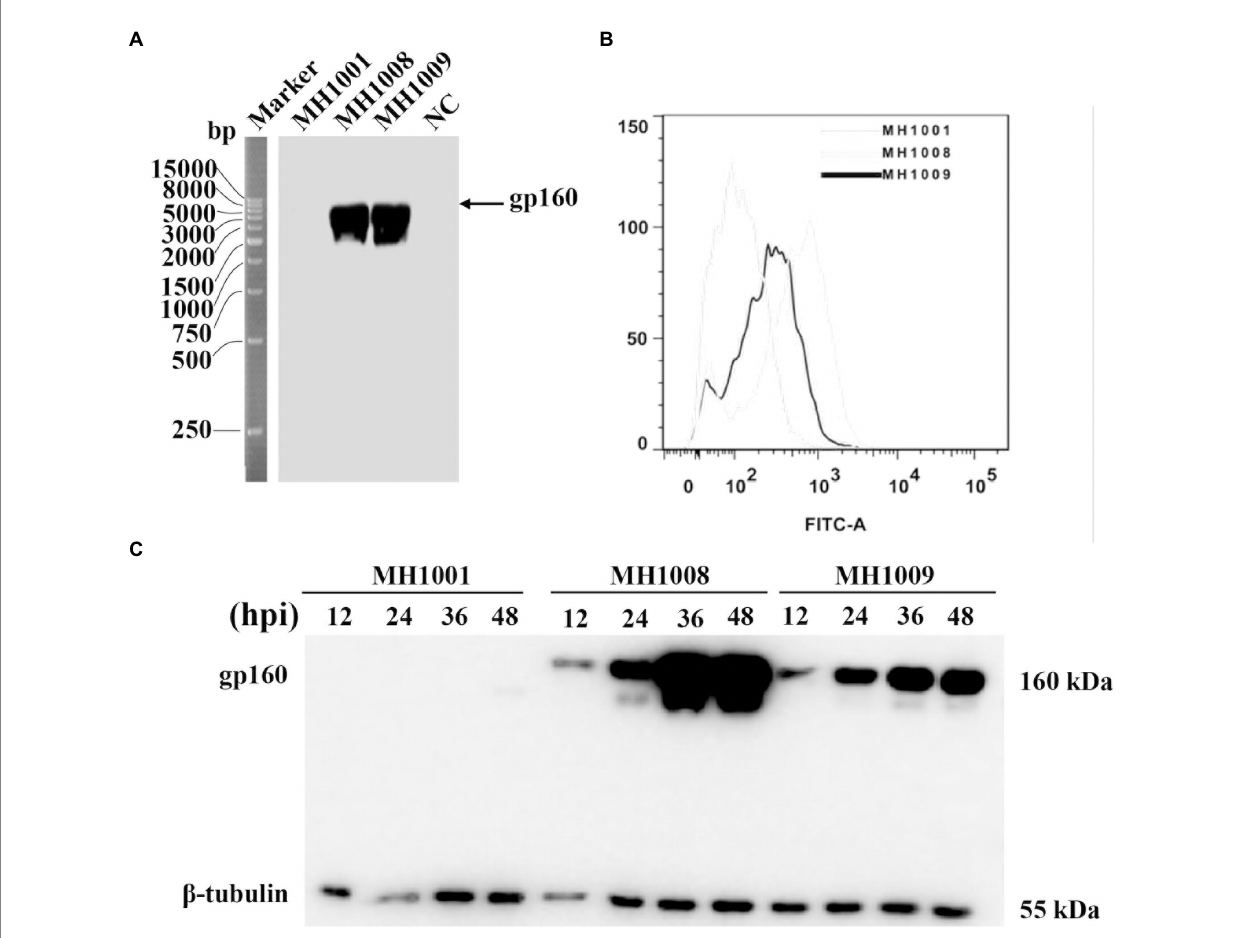
FIGURE 2 Identification and characterization of recombinant virus. (A) Identification of recombinant virus by Southern blot. DNA was isolated from Vero cells infected with MH1001 or recombinant virus clones (MH1008 and MH1009), followed by single enzymatic digestion. DNA hybridization was performed by Southern blot for detection of gp160 gene in the HSV-1 genome. Mock-infected cells served as control. (B) Flow cytometry analysis of gp160 protein surface expression in recombinant virus-infected cells 48 h inoculation. (C) Time course of HIV-1 antigen expression in virus-infected cells. Vero cells were infected with viruses (MH1001, MH1008 or MH1009), and harvested at indicated timepoints for analysis of total gp160 protein expression levels by Western